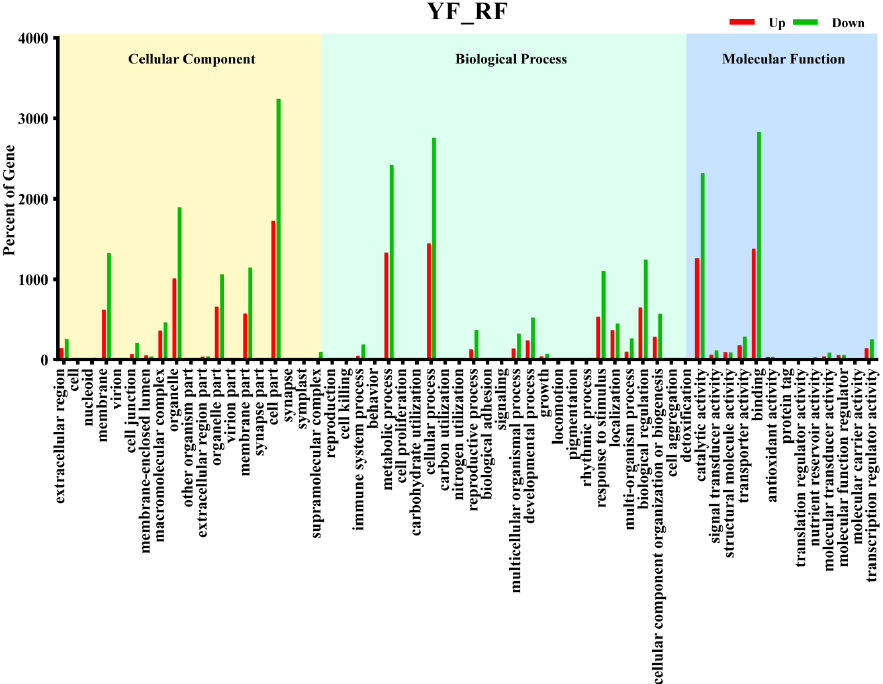
Figure 4. Functional categorization of DEGs with transcriptional changes between the yellow and red fruit. Red indicates up-regulated and green indicated down-regulated genes.